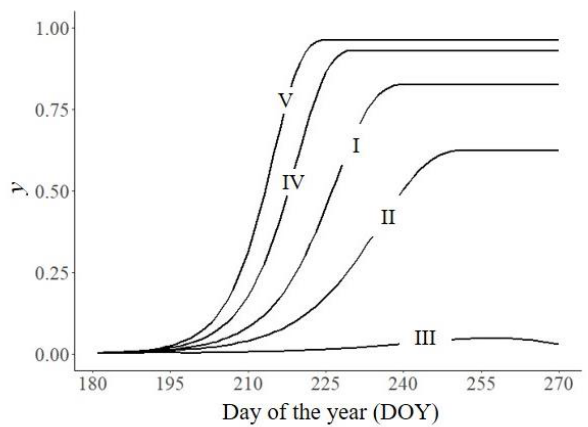
Figure 7. Effect on disease severity ( y ) of spatial aggregation between host plants. I: control, as in Figure 2 ( Dw = 0.7, Db = 0); II and III, reduced within-crop aggregation due to cultivar mixture: II, Dw = 0.5, Db = 0; III, Dw = 0.3, Db = 0; IV and V, increased between-field aggregation due to shortened crop rotation: IV, Dw = 0.7, Db = 0.3; V, Dw = 0.7, Db = 0.6. Symbols are listed in Table 1. Crop rotation, fallows, and crop-free periods influence the degree of between-field aggregation.